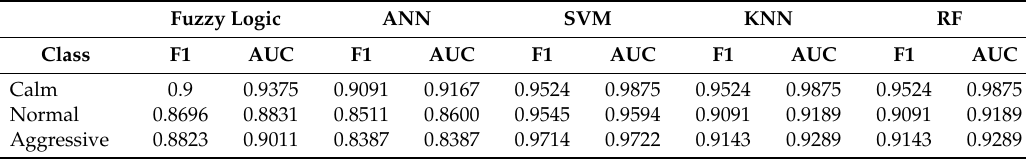
Table 6. F1-score and AUC per driving